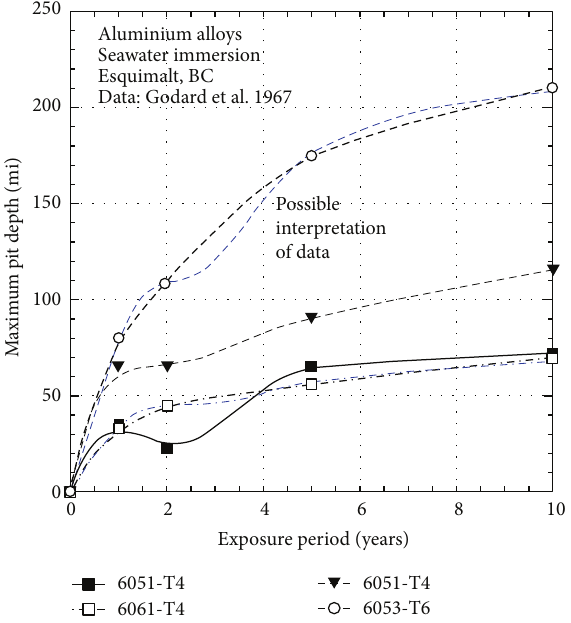
Figure 15: Maximum pit depth trends for low alloy aluminium alloys with oxide stripped off prior to exposure in hard freshwater. Note: horizontal axis is weeks (data from Aziz and Godard